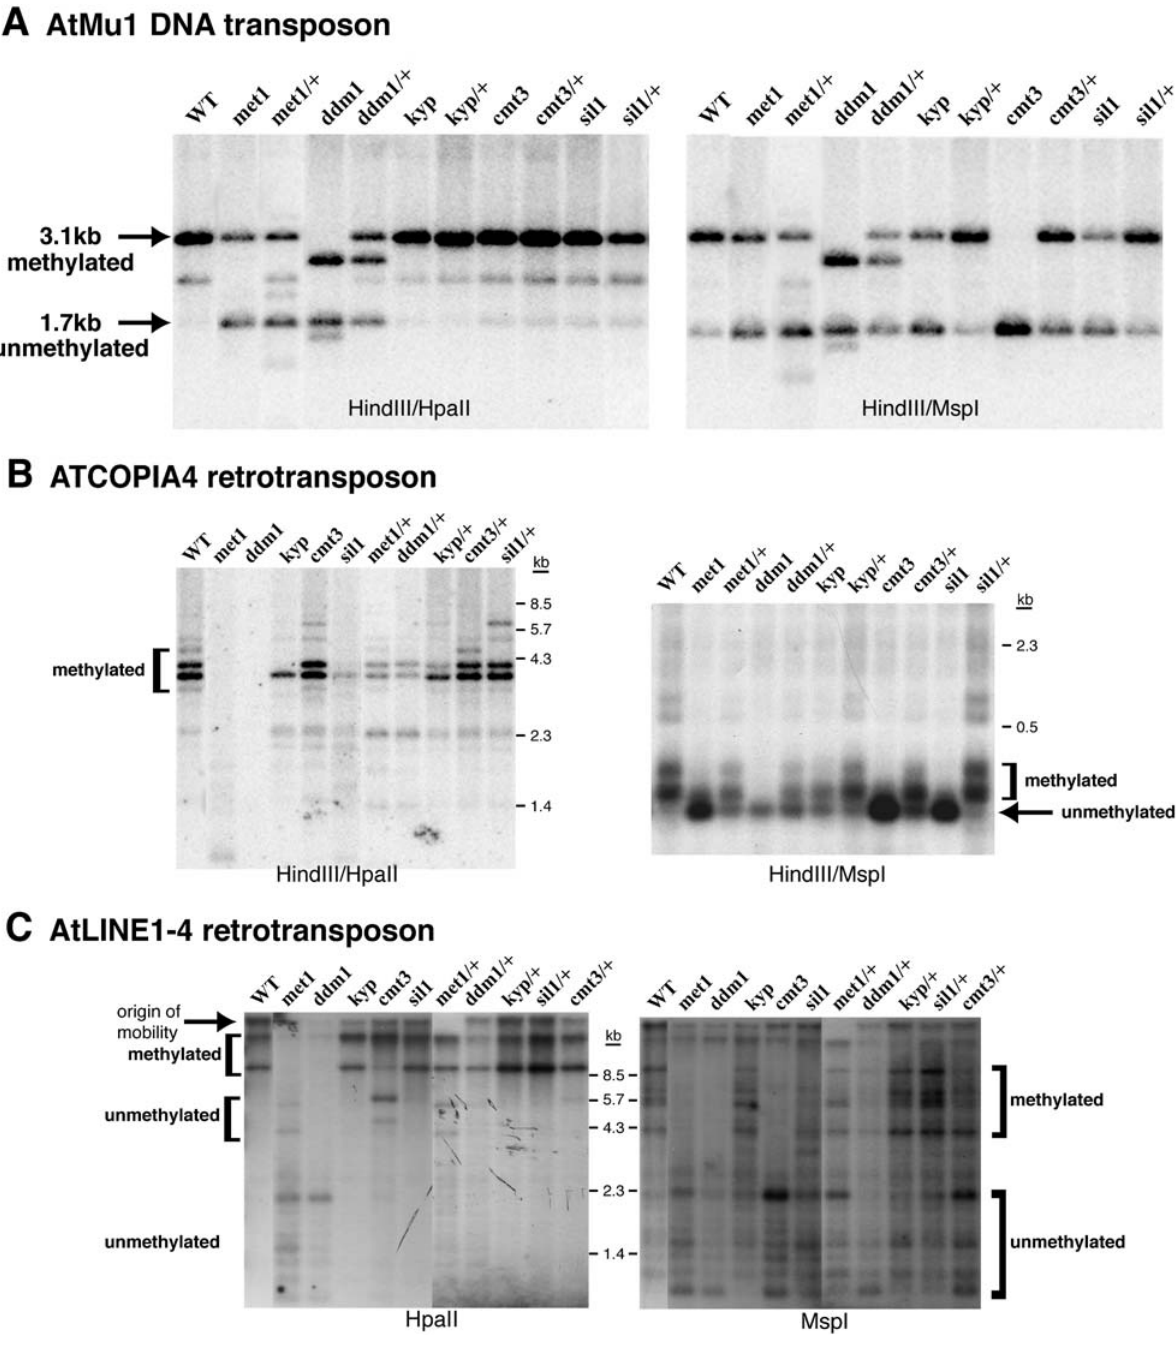
Figure 3. Southern Blot Analysis (A and B) Genomic DNAs prepared from 4-wk-old plants of the indicated mutant and backcrossed (m/ þ ) genotypes were digested with either HindIII and HpaII (left) or HindIII and MspI (right) and used for Southern blot analysis with a probe specific to the DNA transposons AtMu1 and the retrotransposon ATCOPIA4 . The L er genotype is shown. DNA methylation loss for each element within the mutants and their backcrosses is indicated by loss of band intensity relative to WT as indicated by the arrows or brackets. (C) Genomic DNAs from the same genotypes in (A) and (B) were digested with either HpaII (left) or MspI (right) and used for Southern blot analysis with a probe specific to the ATLINE1-4 element. The probe corresponds to a region flanked on both sides by more than five